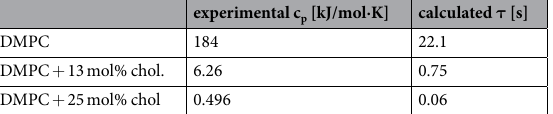
Table 4. Experimental heat capacities at the maximum of the transition for DMPC MLV containing 0 mol%, 13 mol% and 25 mol% taken from Fig. 1. The relaxation times were calculated using eq. (15) assuming L = 7.35·10 8